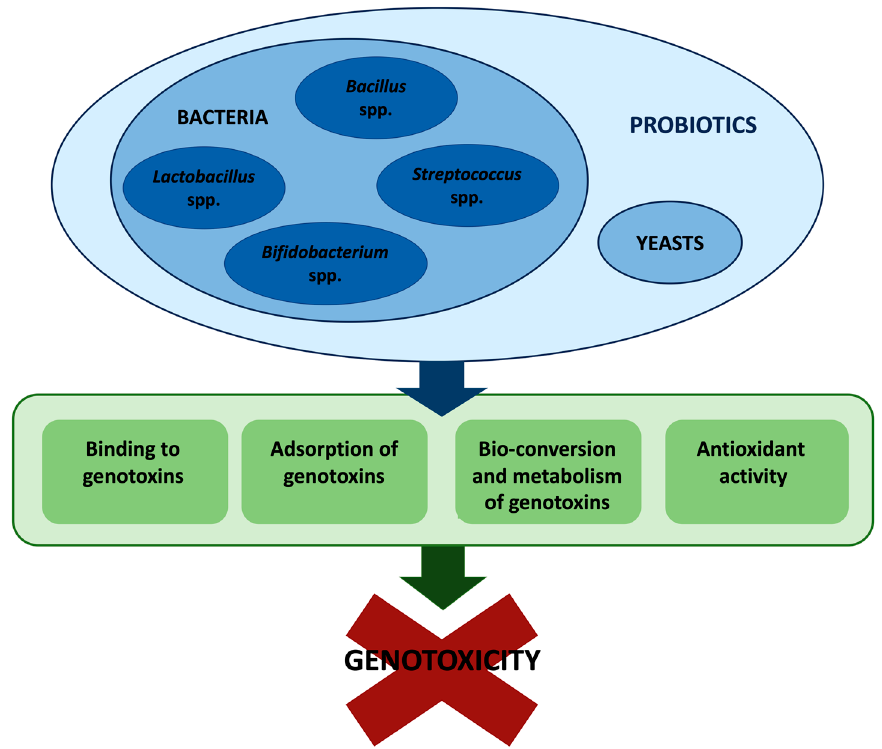
Figure 1. Overview of the mechanisms involved in probiotics’ antigenotoxic activity .